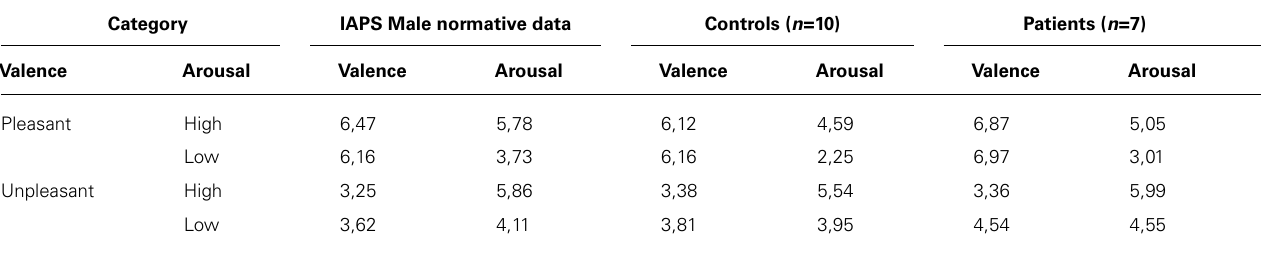
Table 3 | Comparison of the mean arousal and valence ratings between the InternationalAffective Picture System MALE norms (from the Center for the Study of Emotion andAttention, Lang etal., 2008) and the current study subjective evaluations for the controls and our patients. Category